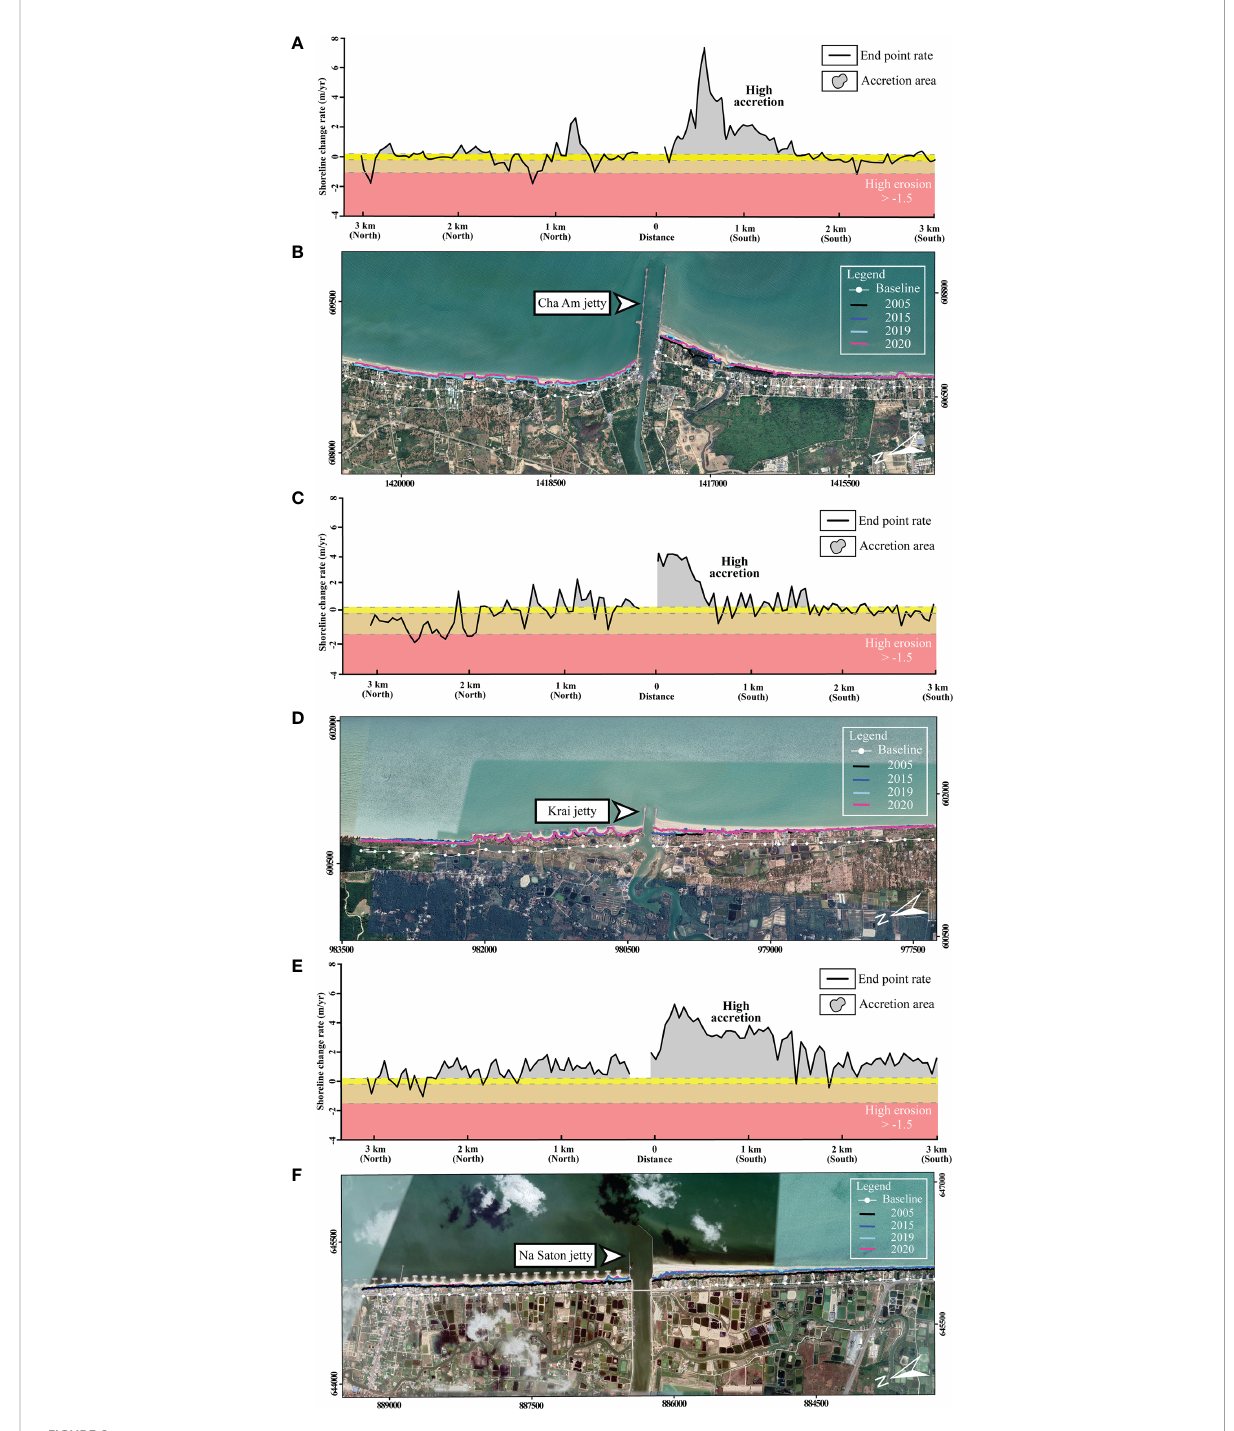
FIGURE 2 Updrift deposition and downdrift erosion at the jetties in this study. (A) Shoreline change rate at the Cha Am jetty, (B) historical coastline near the Cha Am jetty, (C) Shoreline change rate at the Krai jetty, (D) historical coastline near the Krai jetty, (E) Shoreline change rate at the Na Saton jetty, (F) historical coastline near the Na Saton